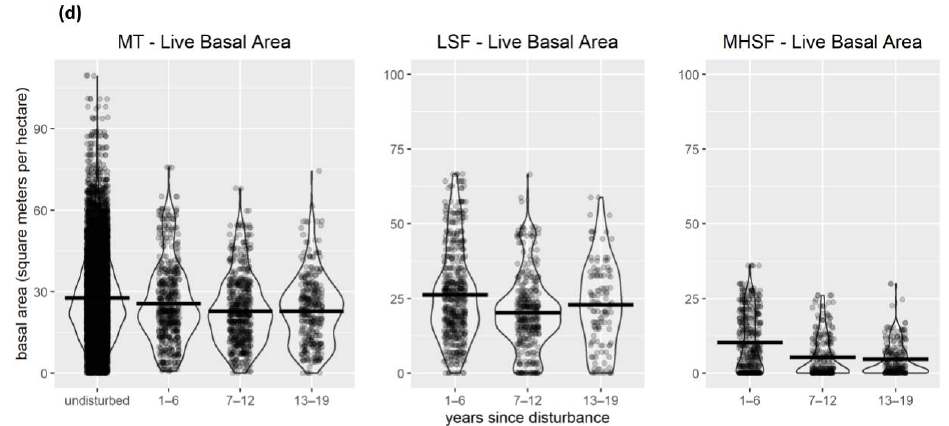
Figure 2. Vegetation measurements at field survey locations within each disturbance type, and sum- marized across three time periods, in comparison to all undisturbed locations. Vegetation measures (also used as covariates in abundance models) include ( a ) shrub cover, ( b ) tree cover, ( c ) snag density, and ( d ) basal area. Violin plots show mean values as a bold horizontal line. MHSF = moderate-high- severity fire; LSF = low-severity fire; MT = mechanical treatment; UO = undisturbed open forest; US = undisturbed shrub; UD = undisturbed dense